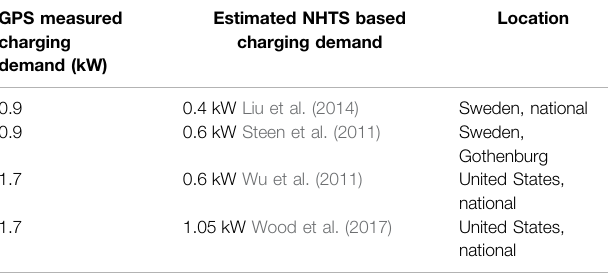
TABLE 2| Comparison ofcharging demandfromGPSmeasured drivingbehavior anddrivingbehaviorfromNHTSforSwedenandtheUnitedStates,expressed as